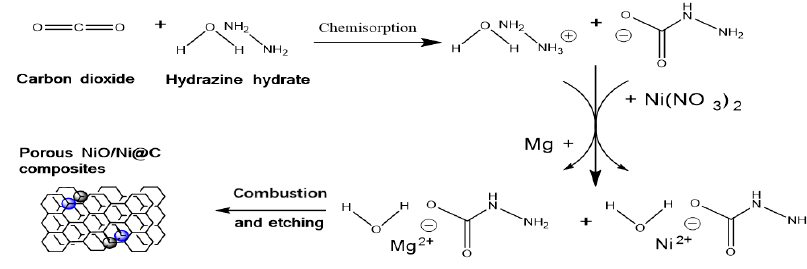
Figure 1. The principle of combustion synthesis of N-doped NiO/Ni@C.